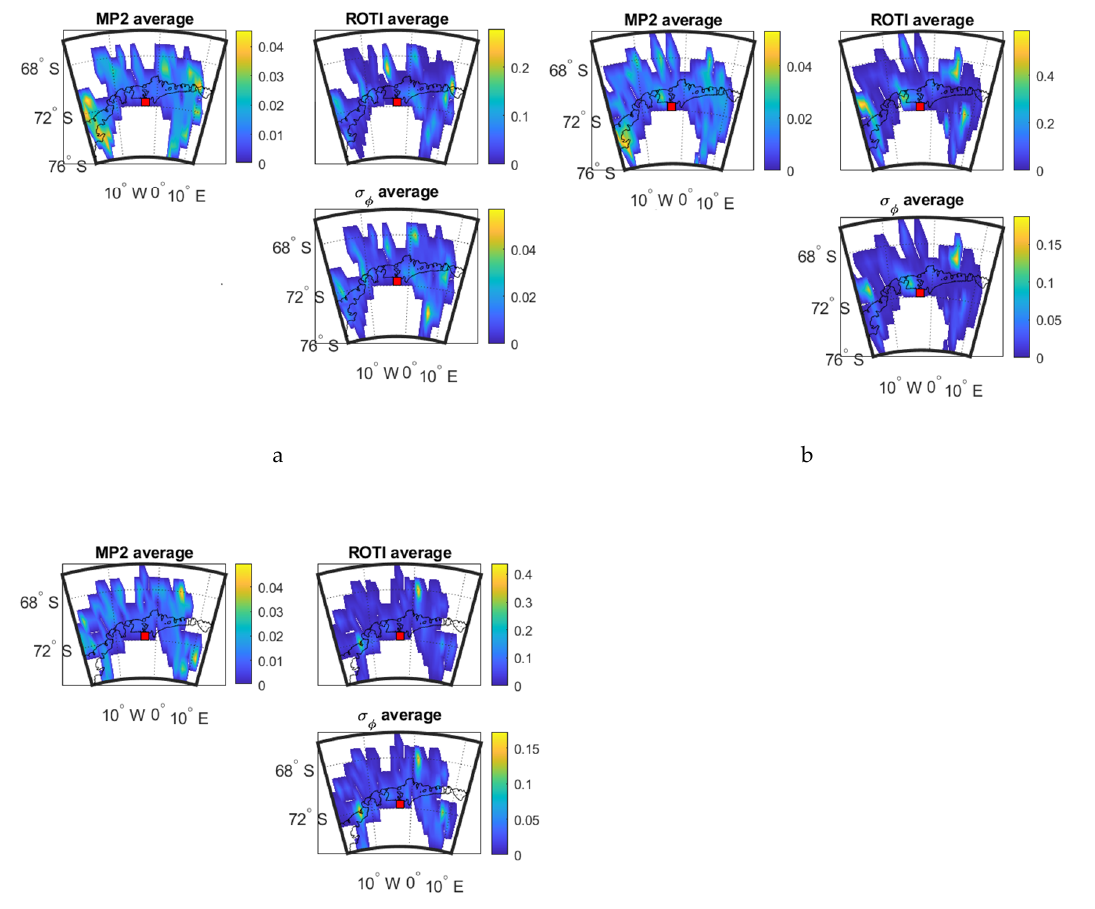
Figure 13. Mean value maps of three parameters at SNA0P station: ( a ) during 18:00:00–24:00:00 UTC on 2 April 2016; ( b ) during 18:00:00–24:00:00 UTC on 13 October 2016; ( c ) during 00:00:00–06:00:00 UTC on 9 May